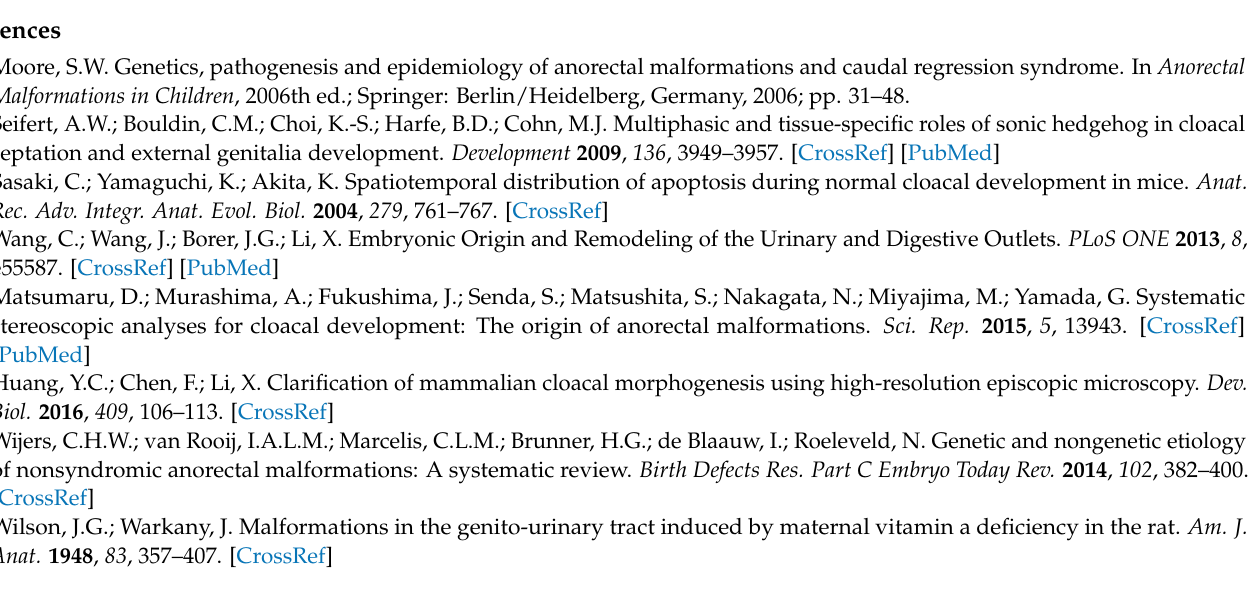
of the urogenital sinus, hindgut and arteries in control and Rarabg ∆ E10.5 mutant embryos at E13.5, Figure S4: External appearance of control and a Rarabg ∆ E9.5 mutant littermates at E13.5; Figure S5: RAR-binding sites at Hoxa13 and Wnt5a loci, Video S1: Control embryo at E11.5, Video S2: Control embryo at E12.5, Video S3: Control embryo at E13.5, Video S4: Rarabg ∆ E10.5 mutant embryo at E11.5, Video S5: Rarabg ∆ E10.5 mutant embryo at E12.5, Video S6: Rarabg ∆ E10.5 mutant embryo at